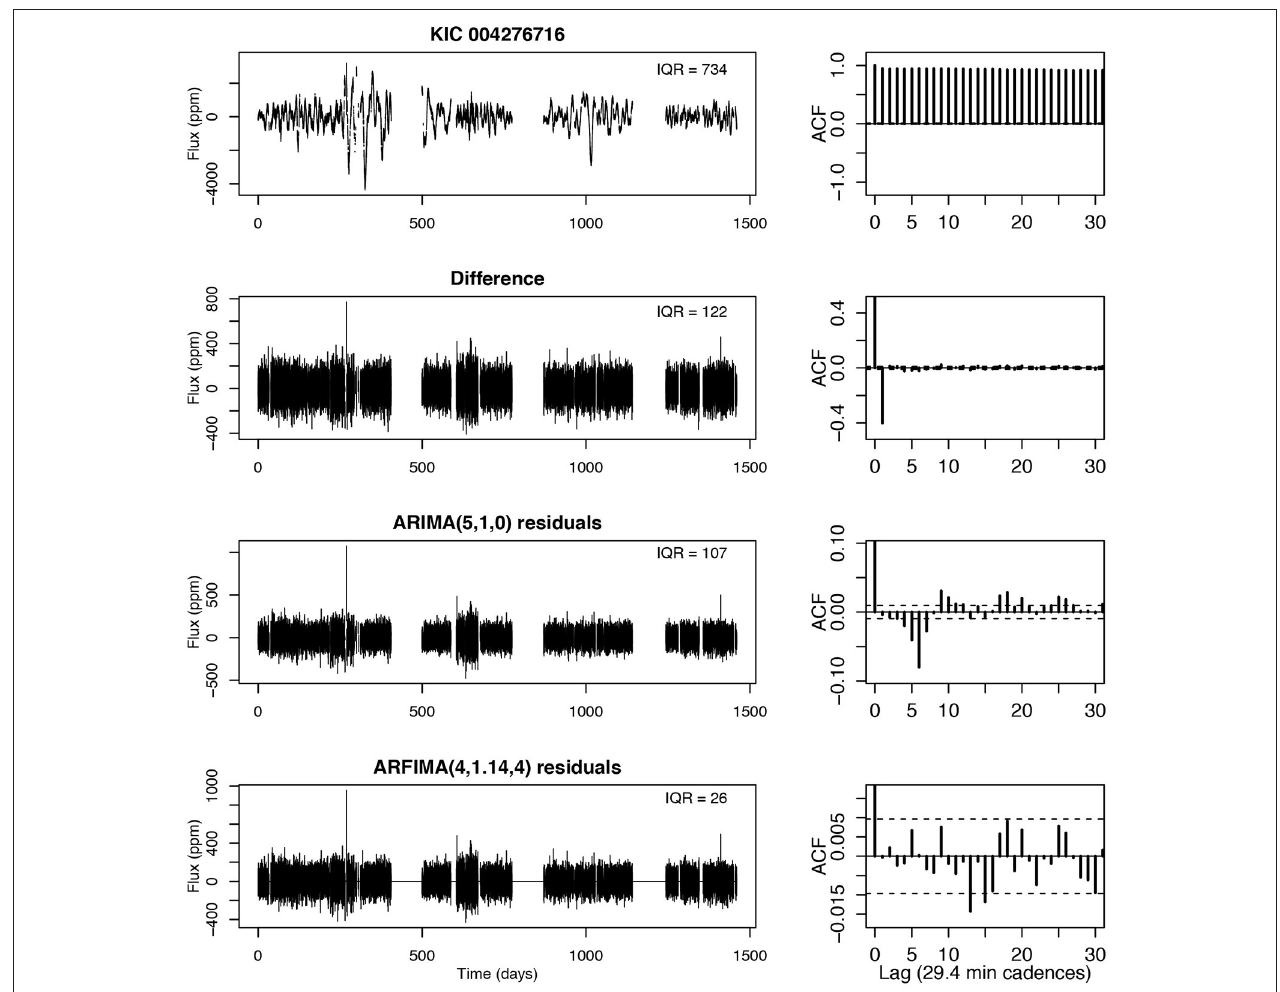
FIGURE 2 | Kepler mission light curve of a spotted with autoregressive modeling.